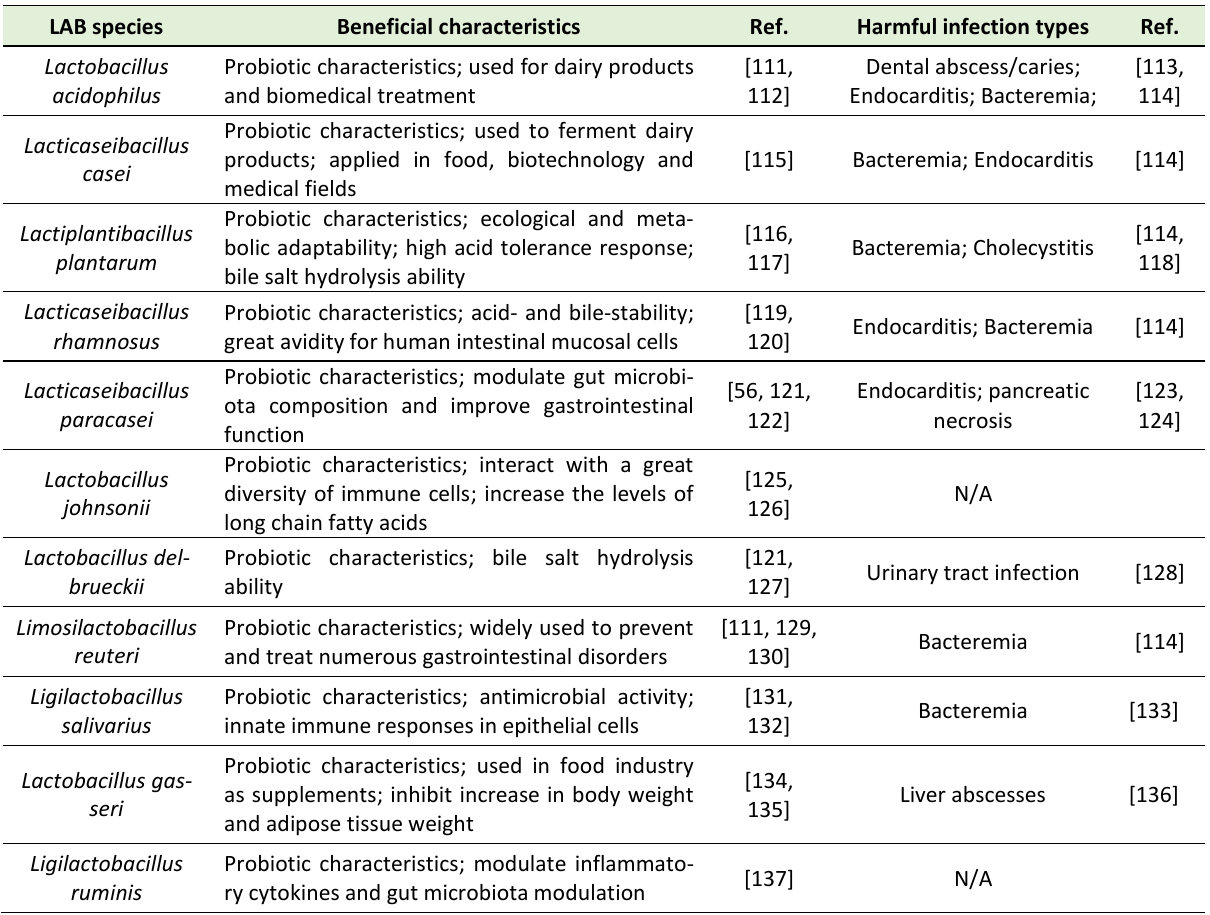
TABLE 1. Beneficial characteristics and harmful infections of LAB species in the gut. LAB species Beneficial characteristics Ref. Harmful infection types